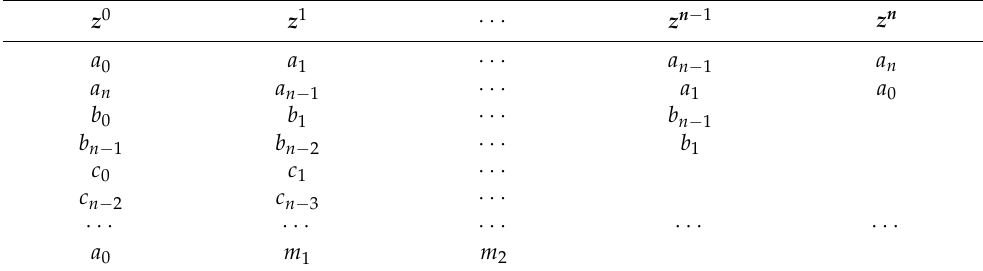
Table 1. The Jury stability criterion for a system with a discrete transfer function and a characteristic Equation